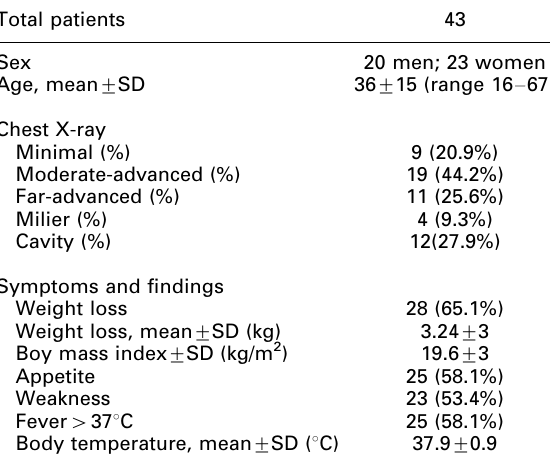
Table 1. Demographics and clinical characteristics of TB patients Total patients